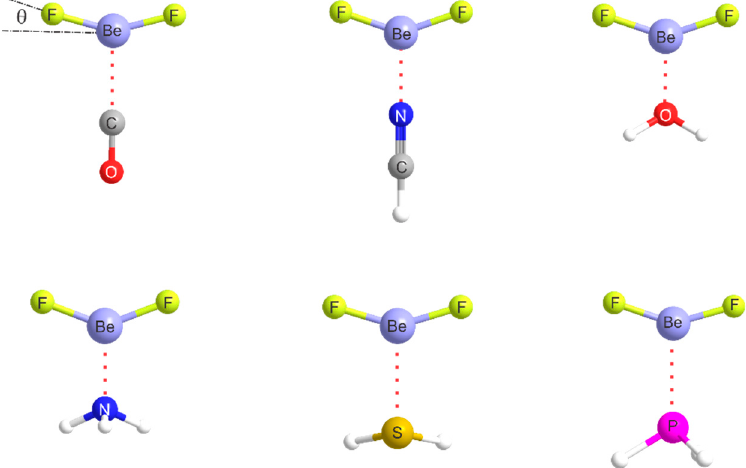
Figure 3. Geometries (drawn to scale) of six B ··· BeF 2 complexes optimized at the CCSD(T)/aug-cc-pVTZ level of theory, where B = CO, HCN, H 2 O, NH 3 , H 2 S and PH 3 .